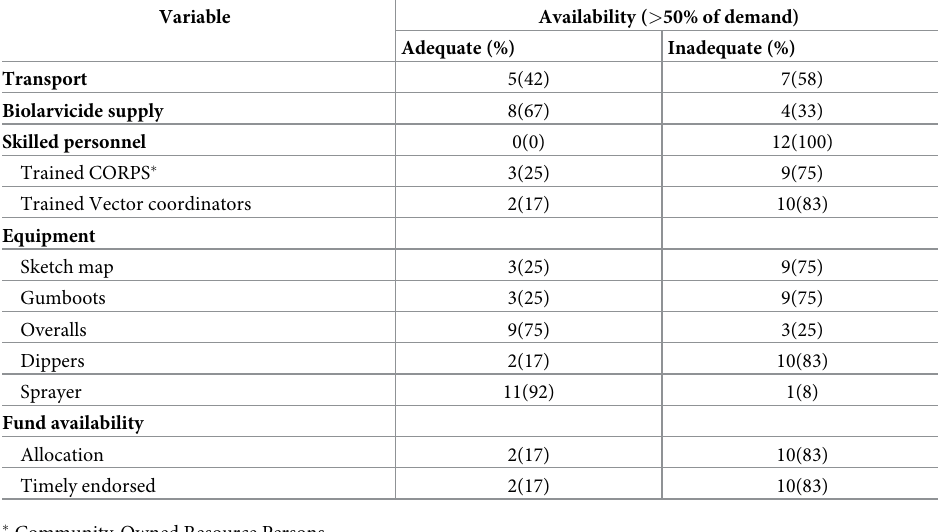
Table 4. Availability of resources for implementation of biolarviciding (n =